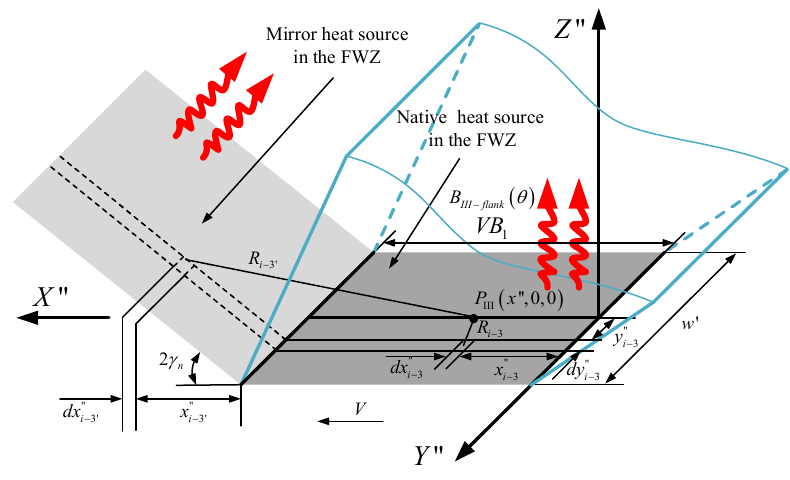
Figure 7. Heat source in the FWZ.